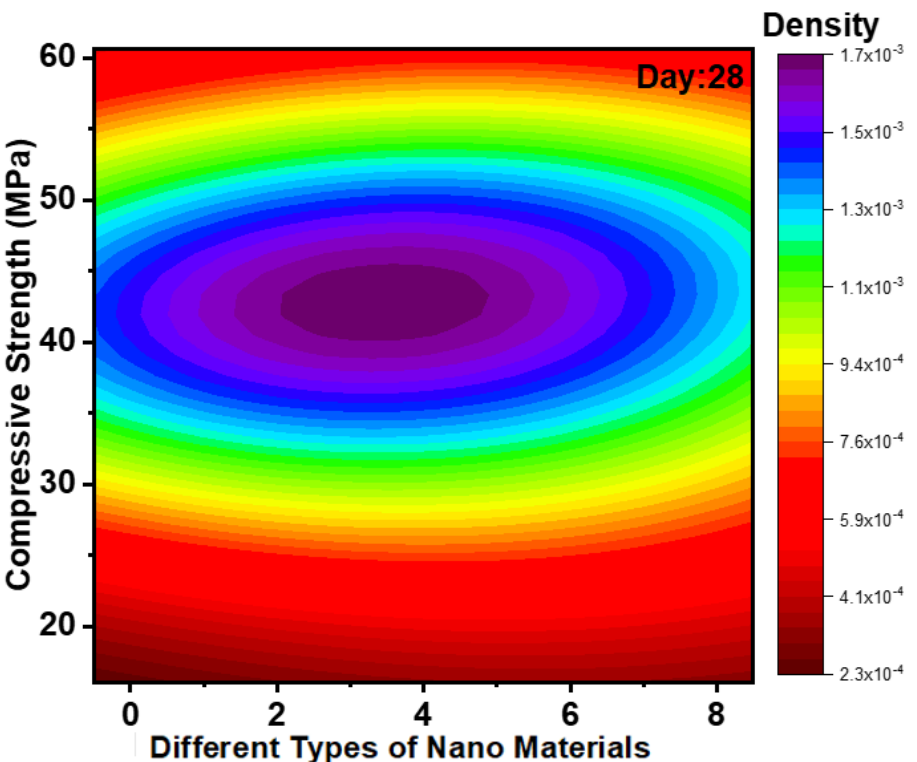
Figure 6. Kernel density plot for CS for day